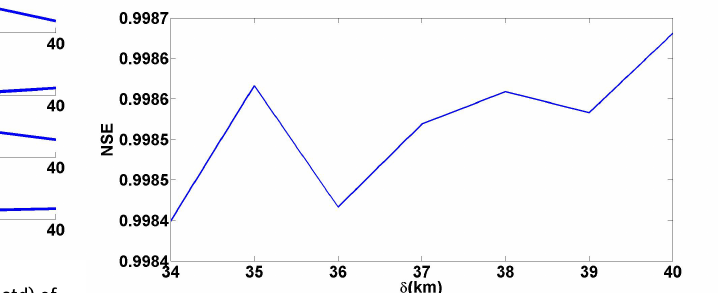
Fig. 4. NSE coefficient, as a function of δ Thus, one can say based on NSE criterion the best value for δ is 40 km .